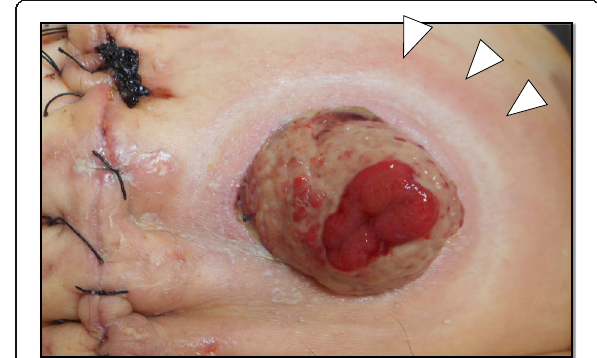
Fig. 1 Slight redness and swelling at the colostomy site (white arrows)